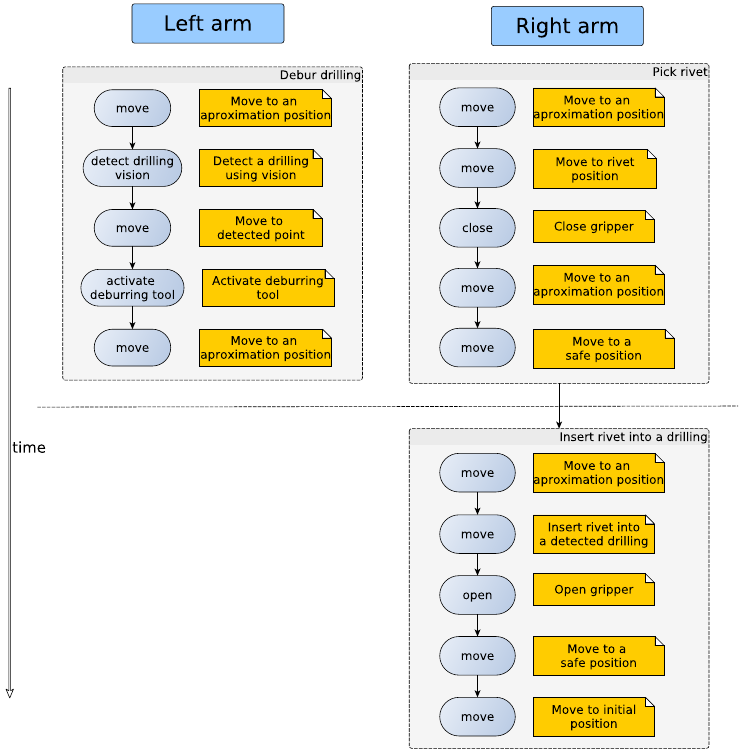
Figure 12. Coordination between both arms’